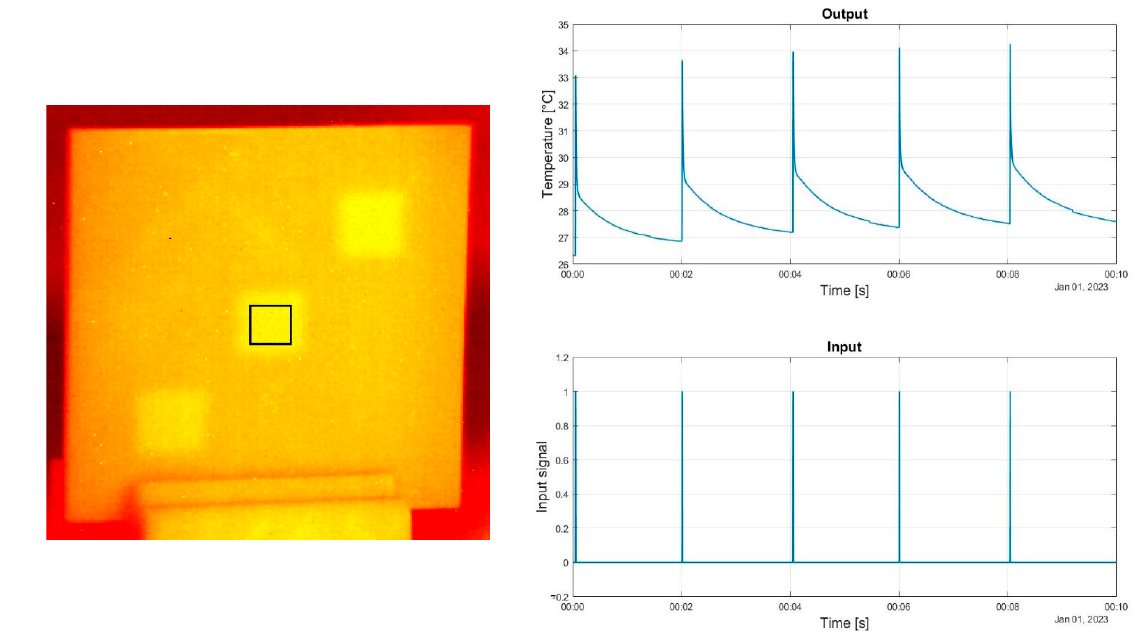
Figure 3. Halogen lamp input and output signal.